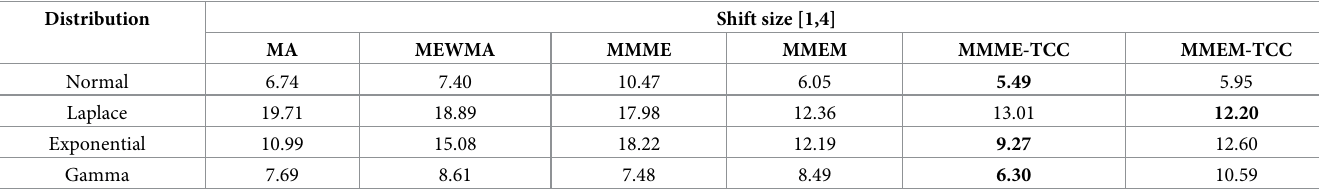
Table 8. Comparison of EARL values for small shift size of the charts’ performance. Distribution Normal Laplace